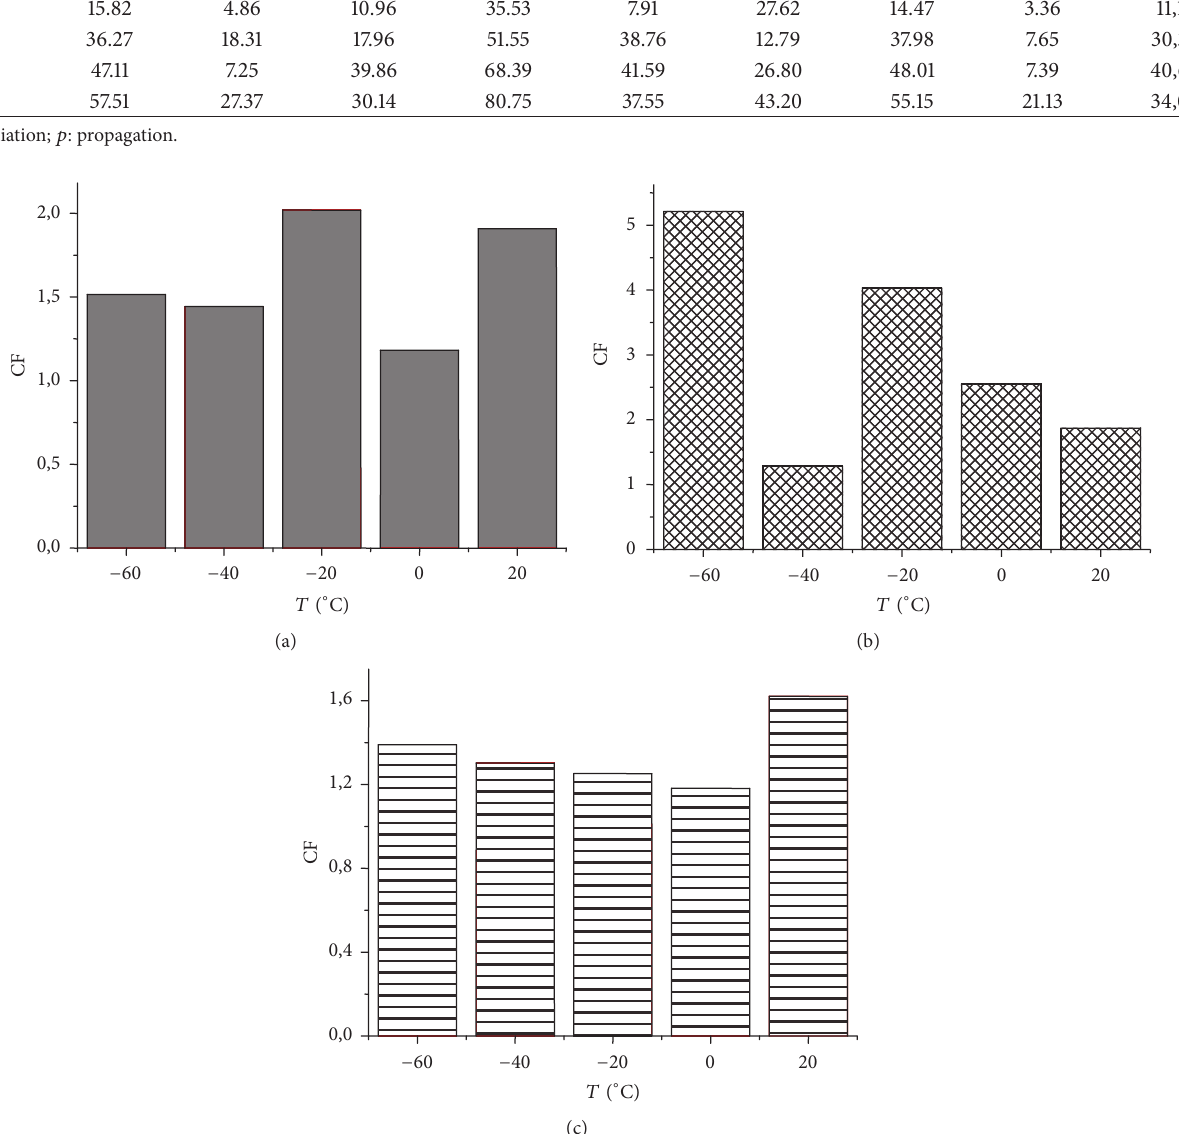
fracture mechanism point of view, it should be